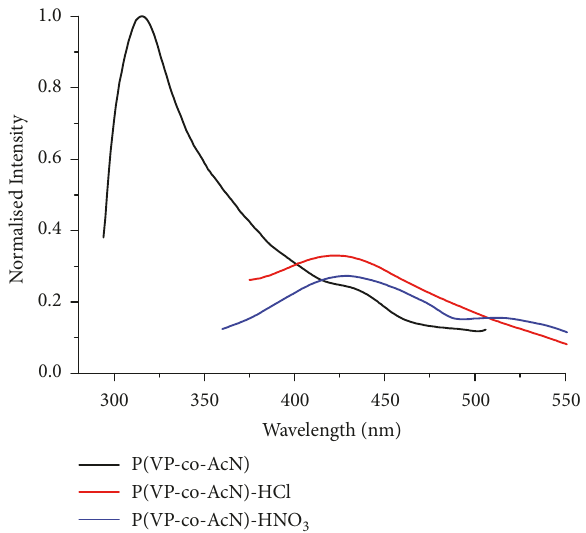
Figure 11: Fluorescence spectra of copolymer and the polyelec-